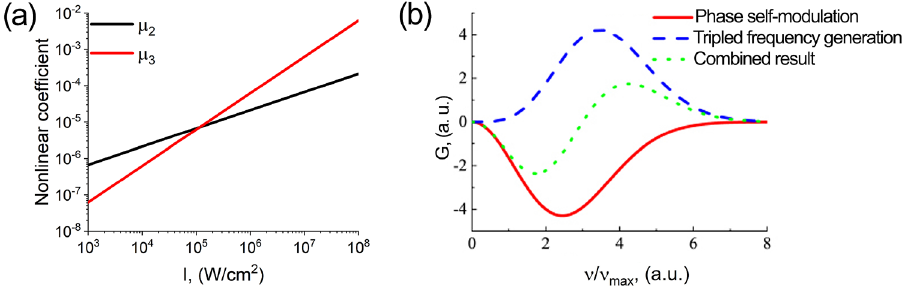
Figure 3. (a) Dependence of quadratic ( µ 2 ) and cubic ( µ 3 ) nonlinear coefficients on the THz pulse intensity.